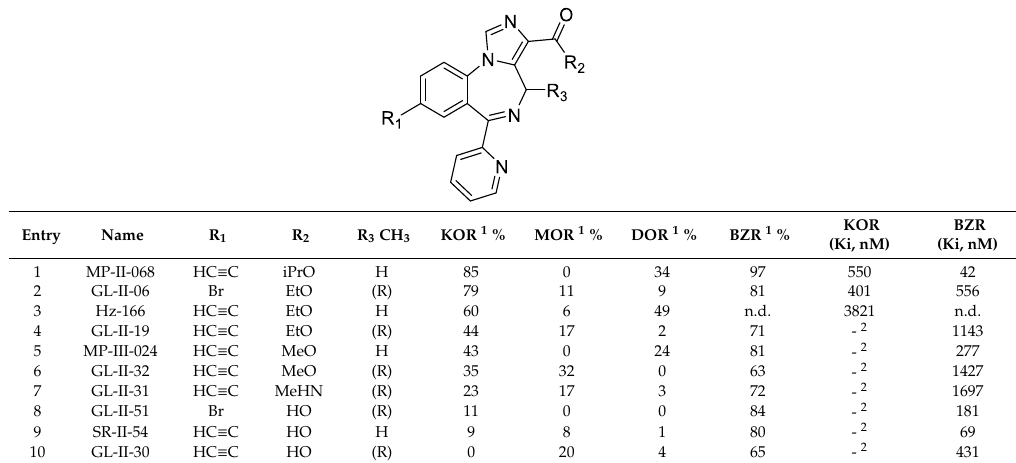
Table 2. Opioid and benzodiazepine receptor binding of 2′ -pyridine substituted imidazodiazepines.